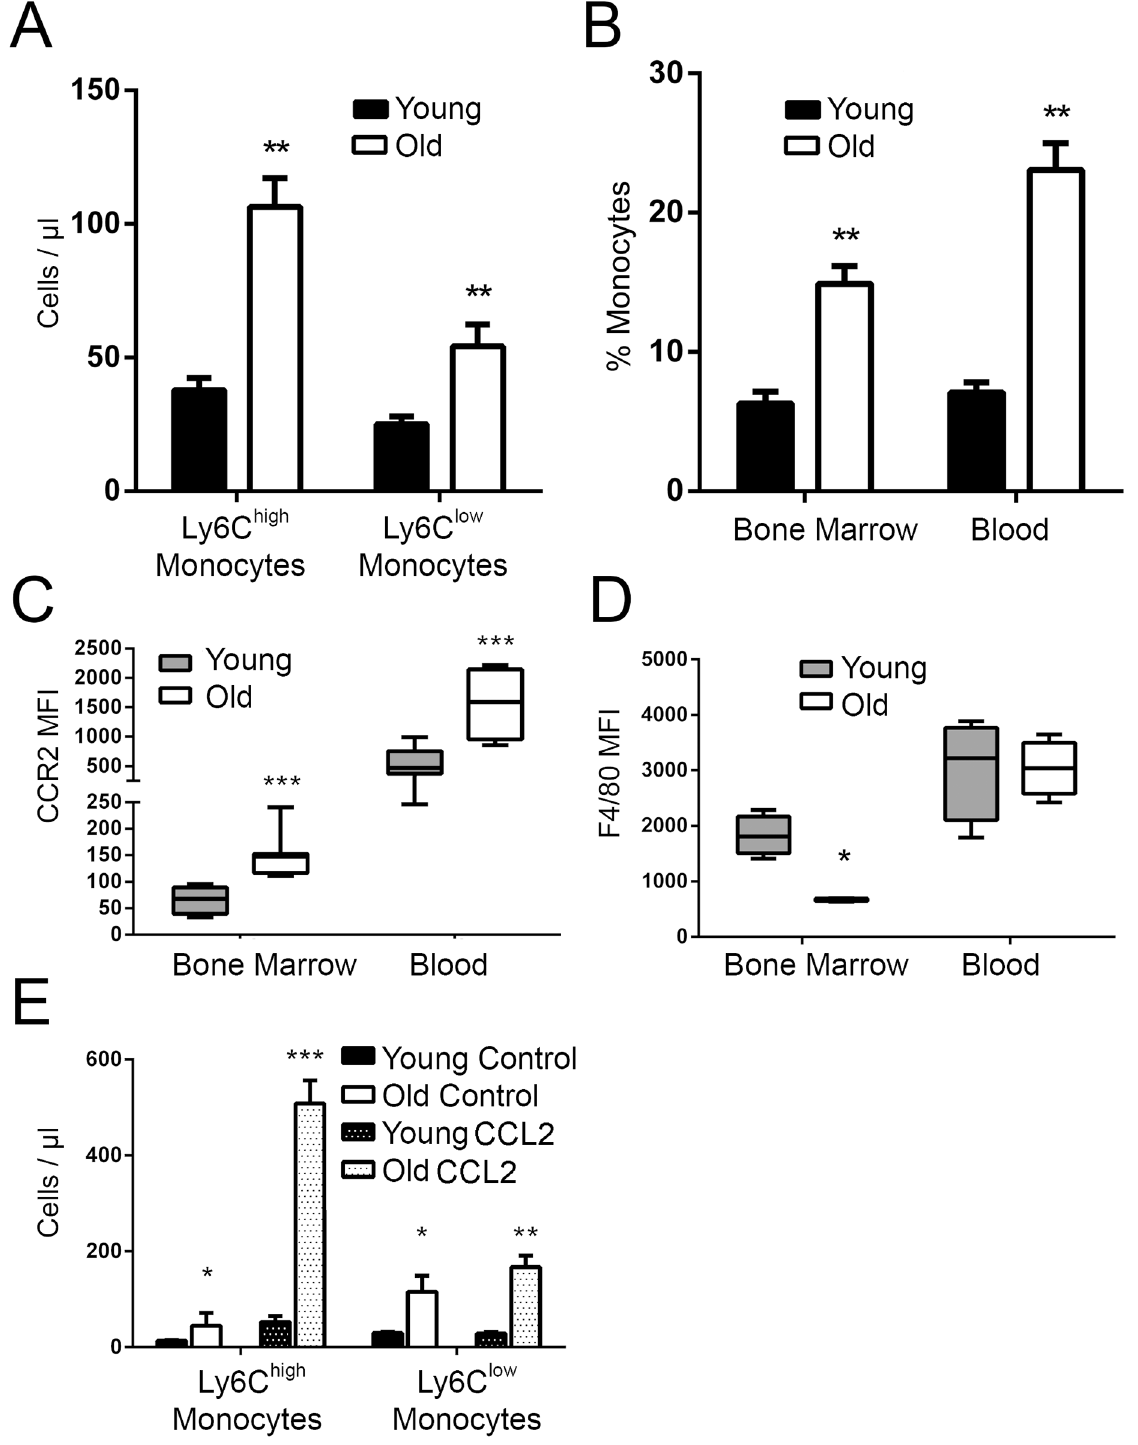
Fig 1. Ly6C high monocytes are increased with age, express more CCR2 and less F4/80. (A) Total numbers of Ly6C high and Ly6C low monocytes were quantitated in the blood of old (18 – 22 mo) WT C57Bl6/J mice and compared to that from young (10 – 14 wk) mice. The data represent the mean ( ± SEM) of 6 mice. (B) Analysis of the Ly6C high monocytes as a percentage of CD45 + cells in the blood and bone marrow of young and old mice ( ± SEM; n = 6). (C) CCR2 expression on Ly6C high monocytes in the bone marrow and blood of old mice is higher than young controls as determined by flow cytometry ( n = 6 – 8). (D) The mean expression of the macrophage maturity marker, F4/80, on Ly6C high monocytes in the bone marrow and blood of young and old mice ( n = 6 – 8). (E)